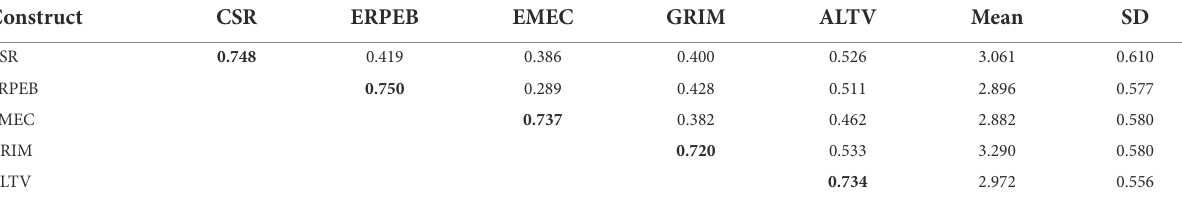
Bold diagonal values represent discriminant validity of a